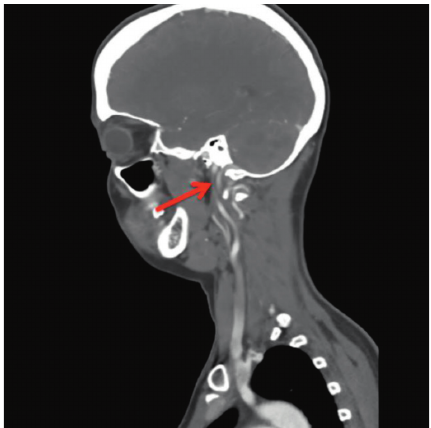
Figure 2: CTA shows a short segment of high-grade narrowing of the cervical right vertebral artery at the C2-3 level.